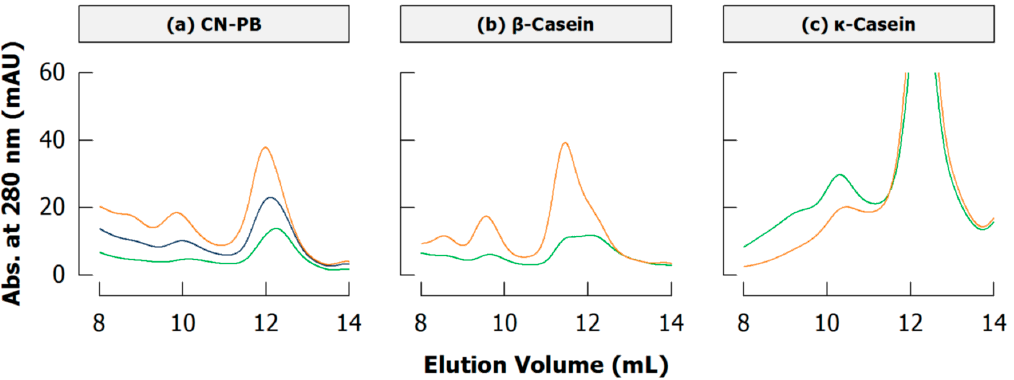
Figure 11. Sections of typical size exclusion chromatograms (Superdex 200 column) of cross-linked ( a ) casein in phosphate buffer (CN-PB); ( b ) β -casein; and ( c ) κ -casein depicting monomers (~12 mL) and dimers (~10 mL) (originally presented in [94]; see also Appendix A.4). Samples were incubated with transglutaminase for 1 (orange), 2 (blue), or 3 h (green) (see Appendix A.1 for experimental details).